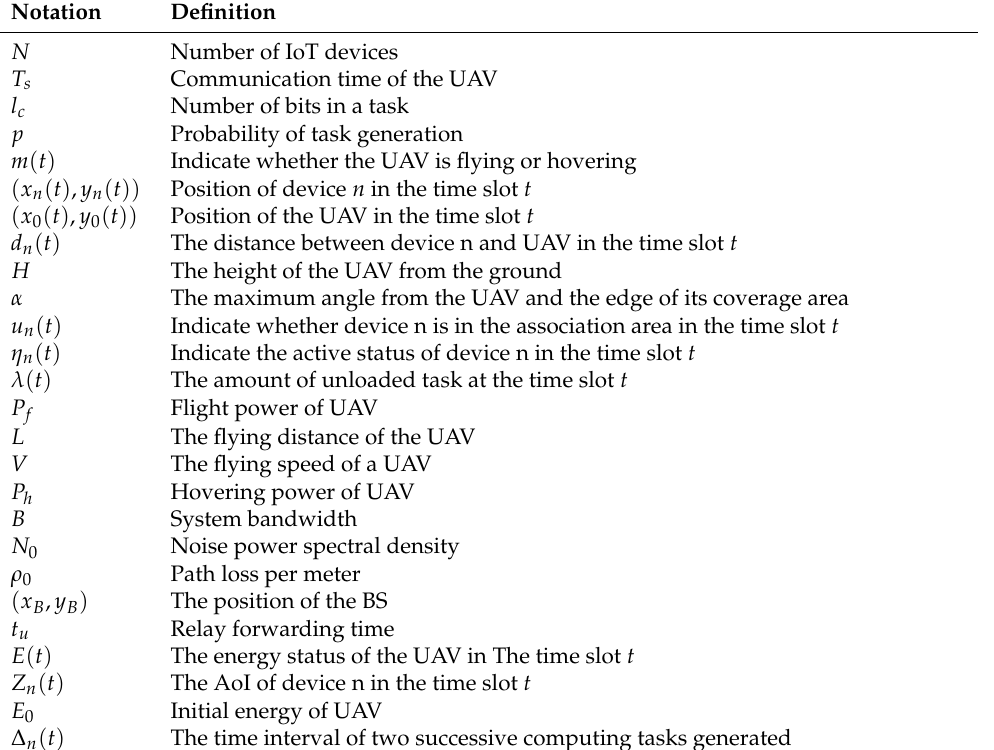
Table 1. Notations and